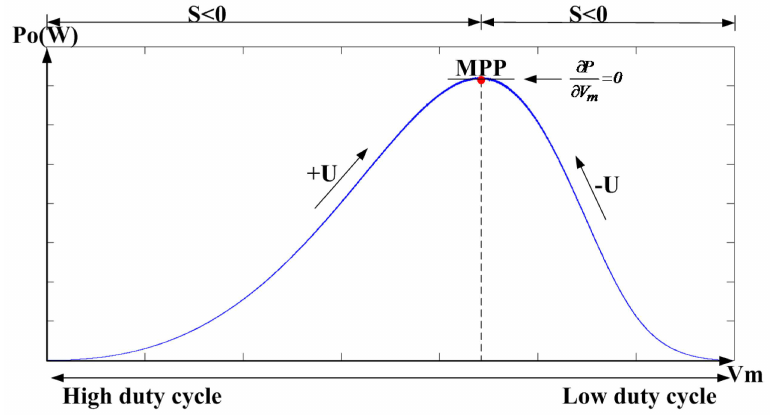
Figure 5. Duty cycle versus operation